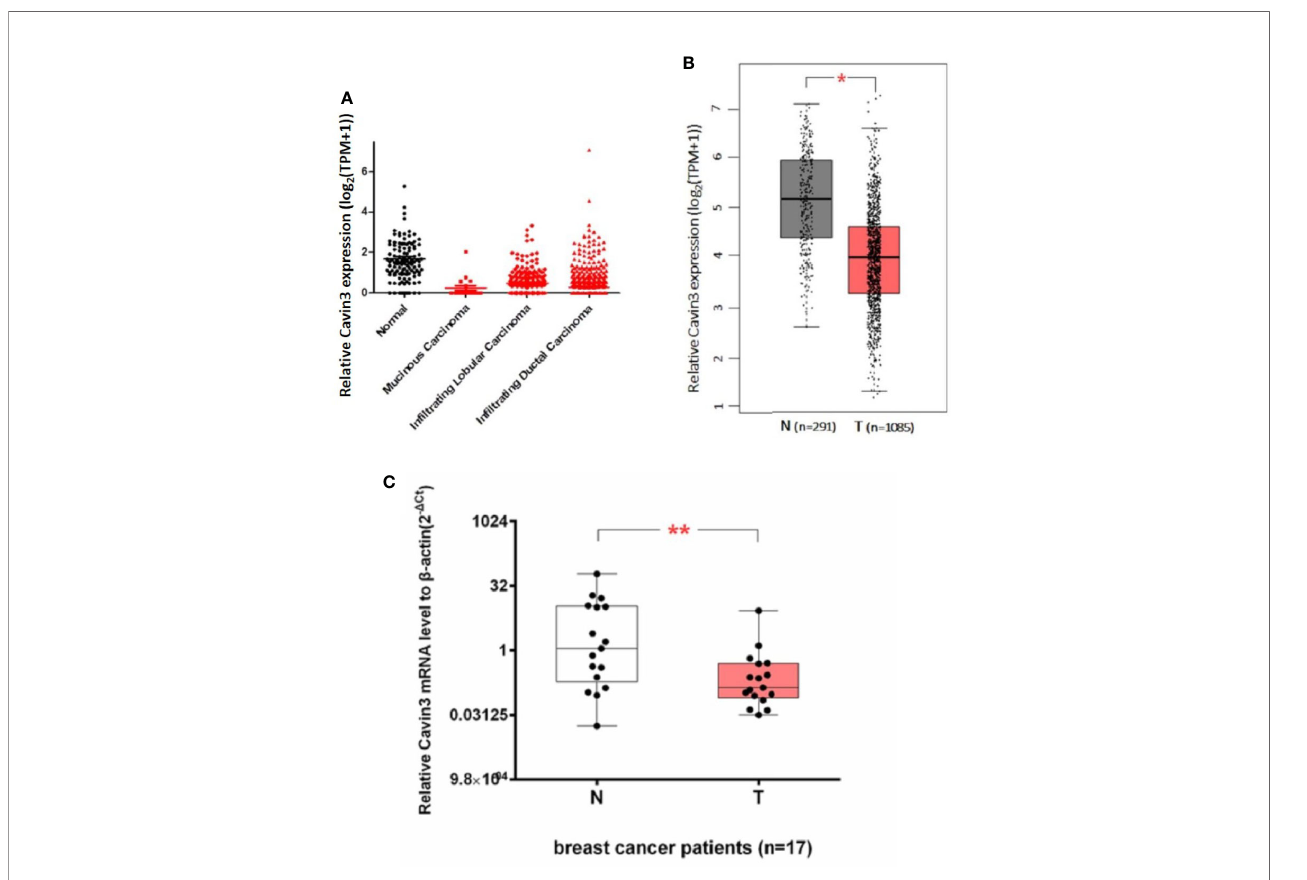
FIGURE 1 | Lower expression of Cavin3 mRNA in breast cancer samples compared with normal control. (A) TCGA database; (B) GTEx database; (C) 17paired fresh-frozen breast tumor and adjacent normal tissues. *p<0.05; **p<0.01.